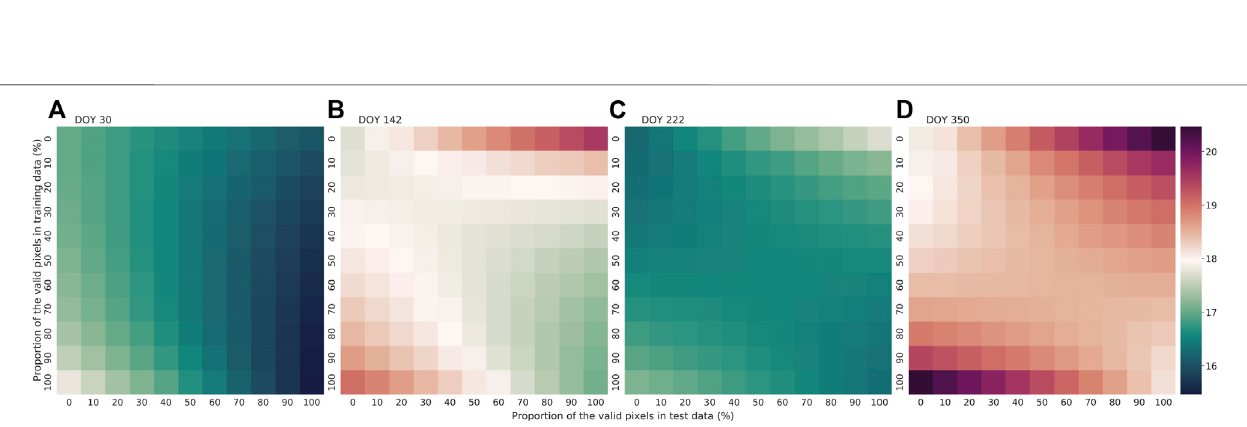
FIGURE 9 | RMSE of single-date images from four seasons with respect to different proportions of MOPSTM gap- fi lled and valid observations involved in both training datasets and test datasets in random forest models. Four Landsat 8 images were acquired from (A) DOY (day ofyear) 30 in dry and hot season, (B) DOY 142 in long rain season, (C) DOY 222 in dry and cool season, and (D) DOY 350 in short rain season in 2015.